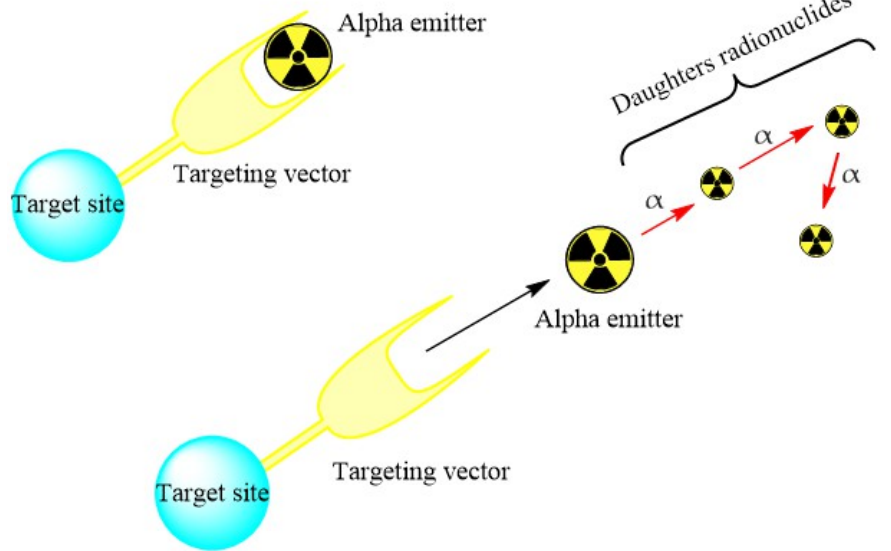
Figure 7. Schematic representation of recoil energy.